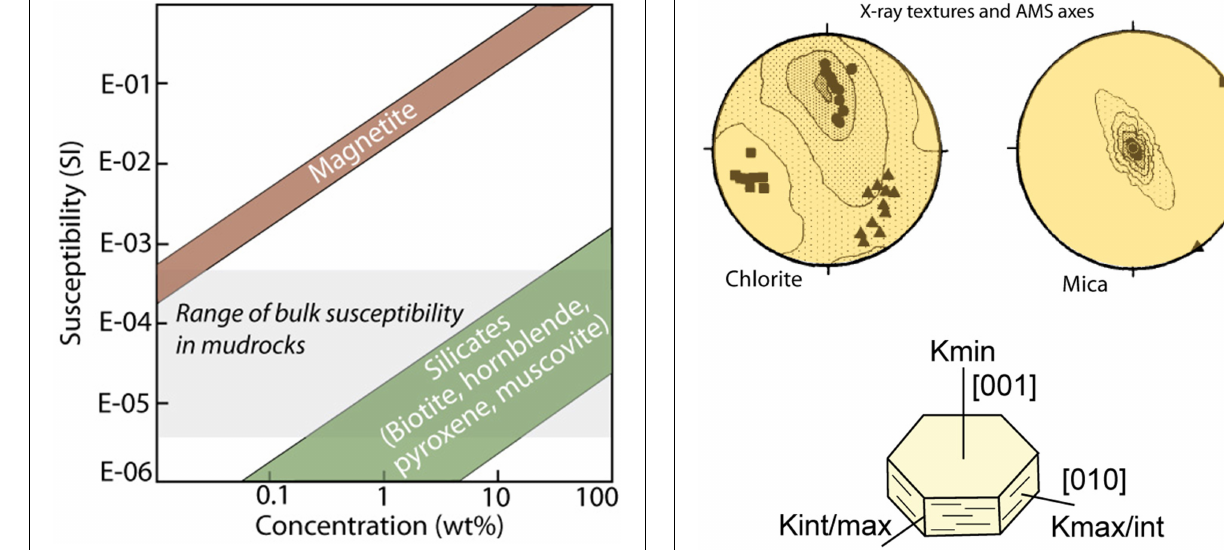
FIGURE 1 | Bulk susceptibility and mineral contribution. The total susceptibility in a given rock will depend on both the intrinsic susceptibility and the concentration of the individual minerals. Magnetite (ferromagnetic) and some common rock-forming silicates have been shown as a reference. The gray, horizontal bar shows the susceptibility range for most mudrocks, revealing that the contribution by paramagnetic grains (in particular phyllosilicate) is larger than magnetite.